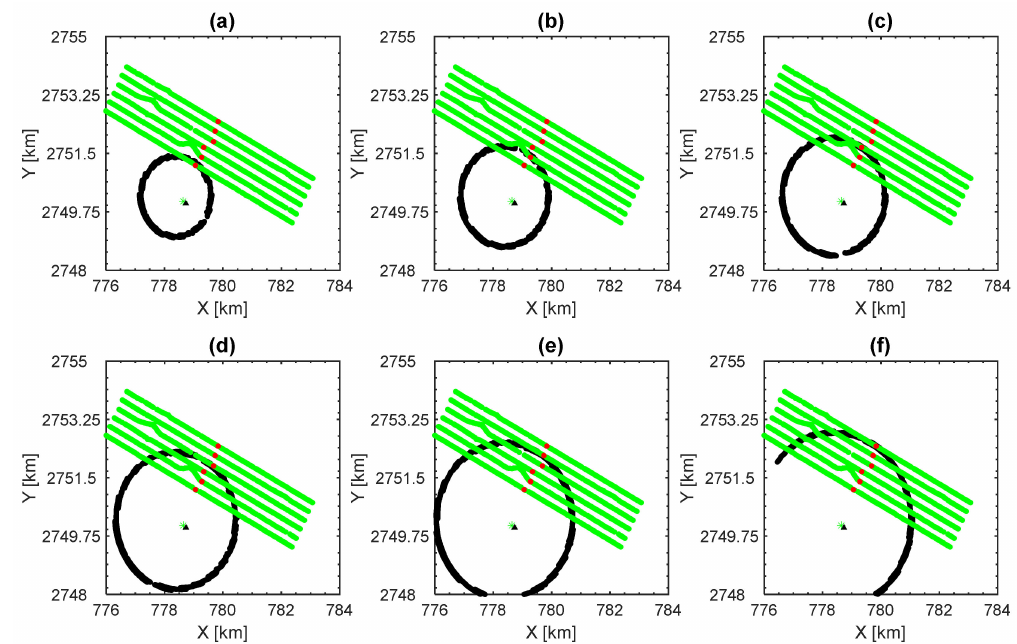
Figure 5. Maps showing locations of selected VSP shots (black dots) at offsets of ( a ) 1300 m, ( b ) 1400 m, ( c ) 1650 m, ( d ) 1750 m, ( e ) 1850 m and ( f ) 2000 m from the wellhead (black triangle). In addition, also shown are 3D OBC receiver (geophones and hydrophones) lines (green dots) that recorded the data for the closest shot (green star) to the wellhead (black triangle) with a distance of 112 m. The geophones and hydrophones that have the smallest offset and closest to a VSP shot with same offset, at each receiver line are highlighted by red